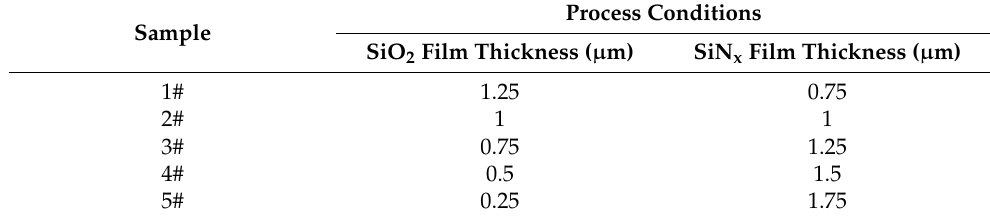
Table 2. This Process experimental